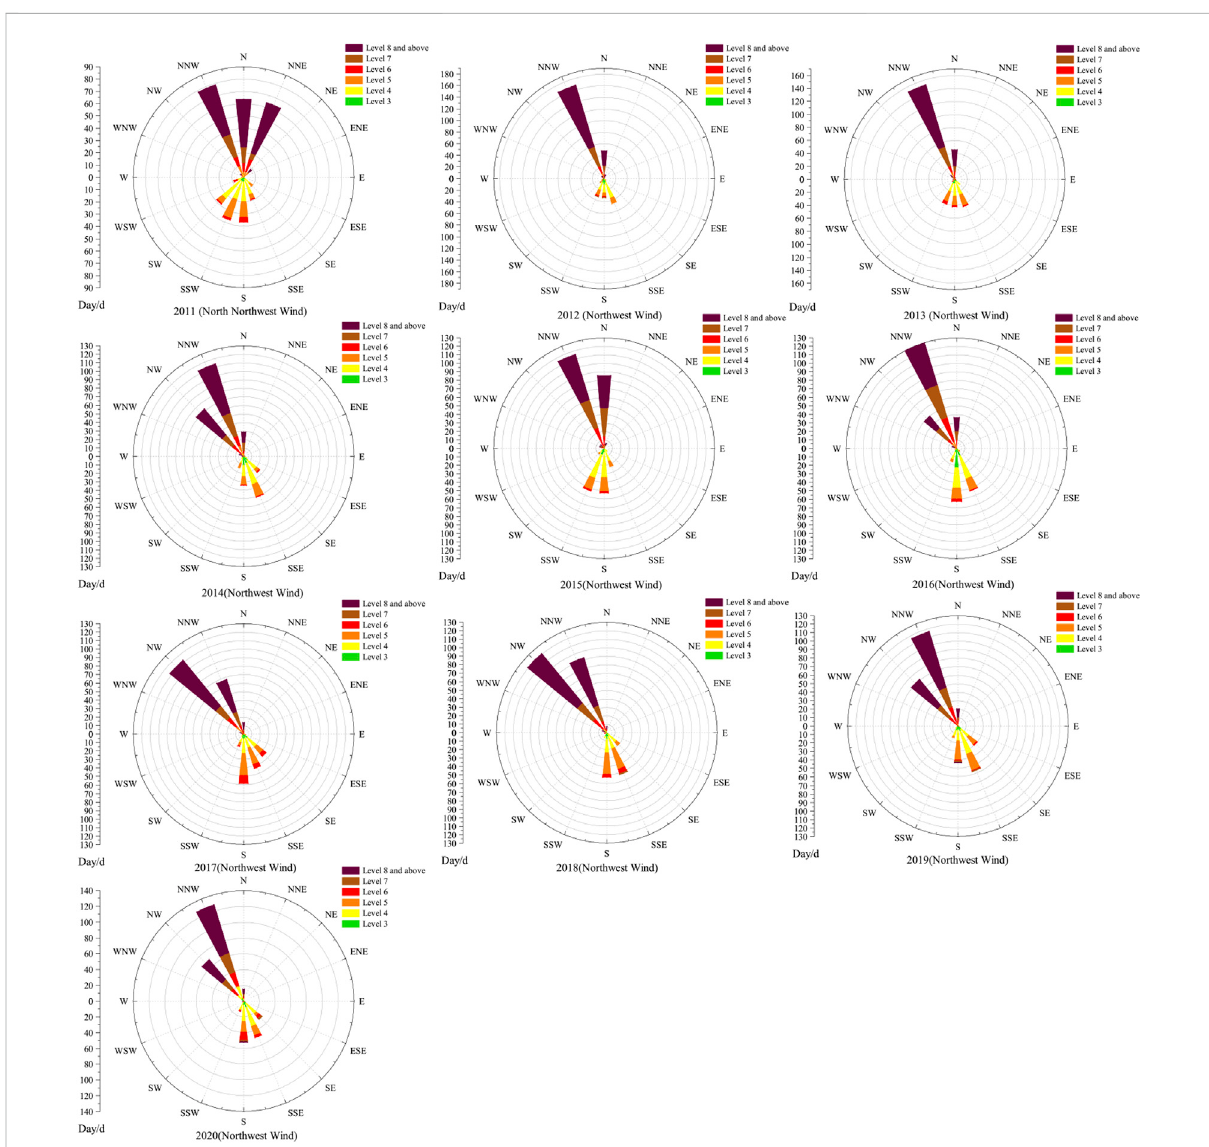
FIGURE 11 Schematic diagrams of annual wind speed and direction of Alashankou station ( 2011 to